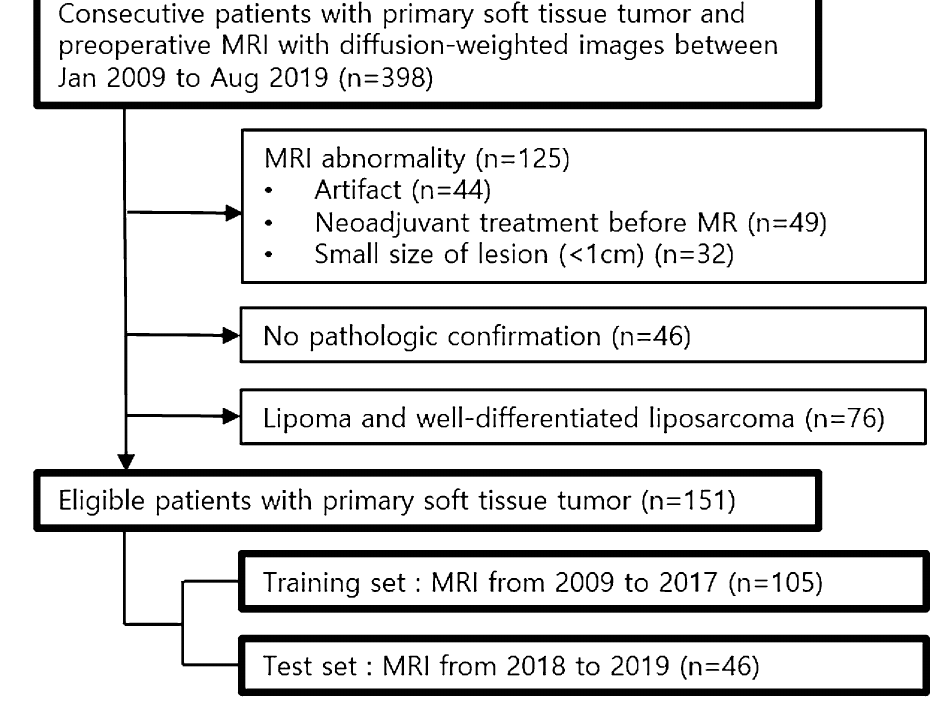
Figure 3. Flowchart of patient